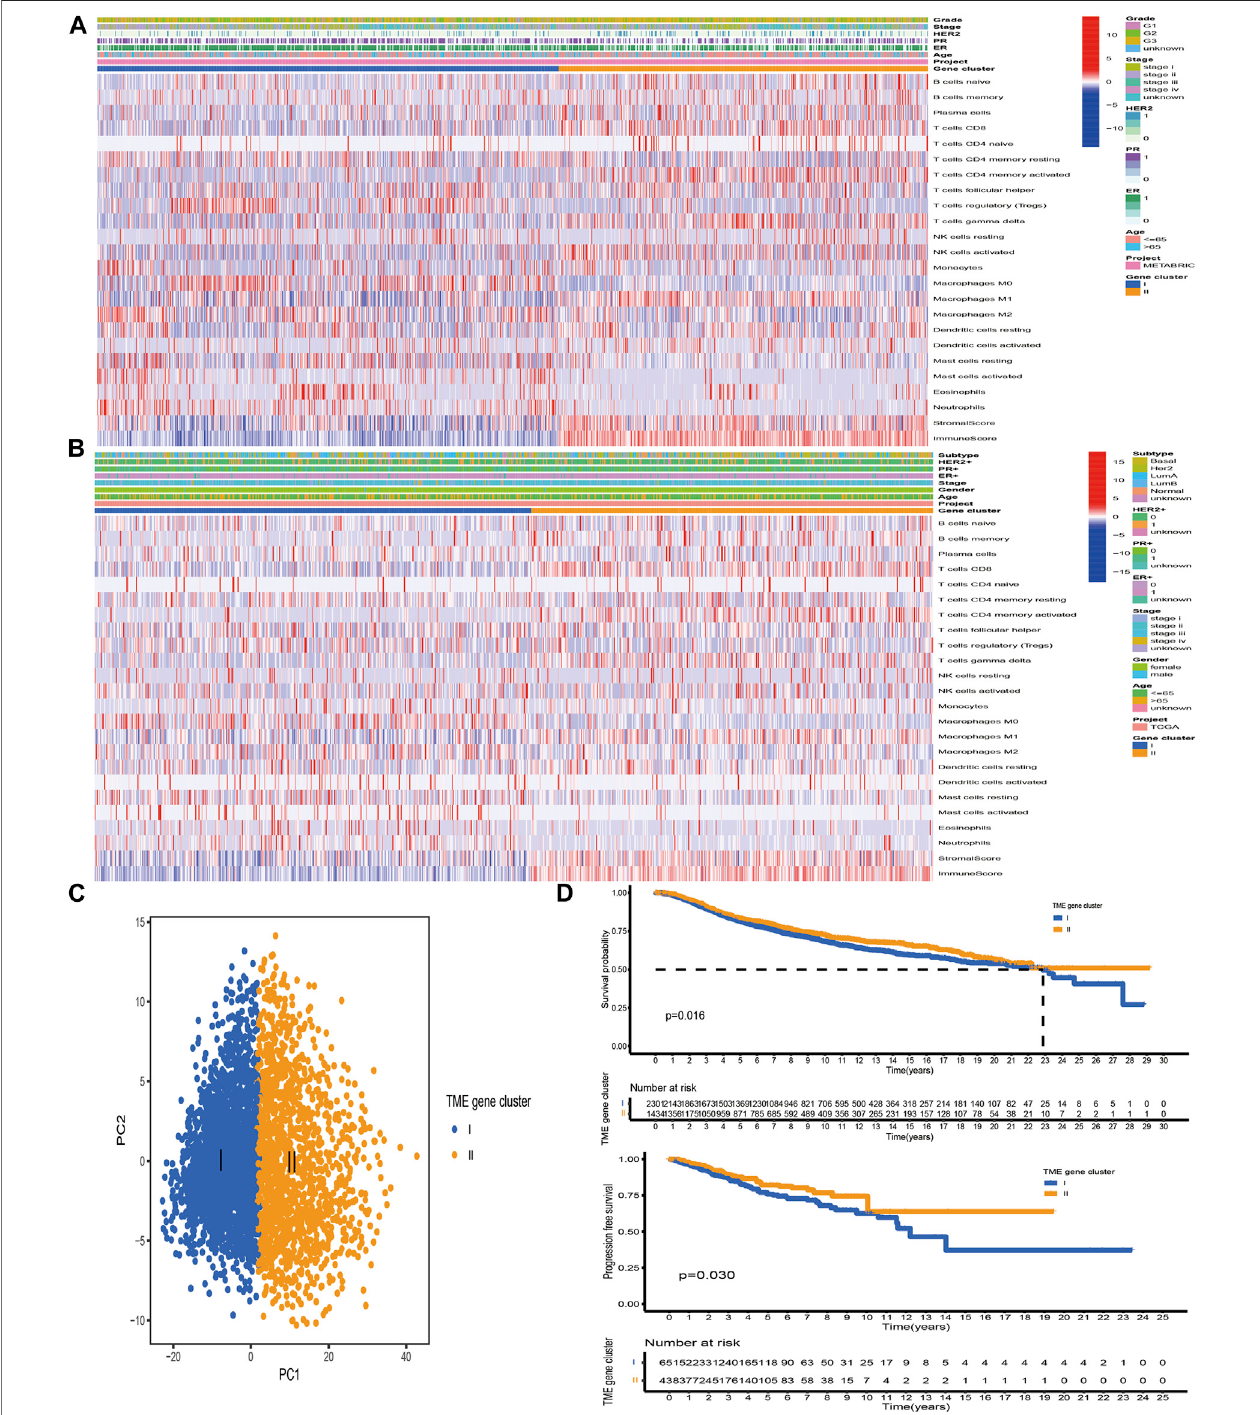
FIGURE 4 | Construction of TME-related gene signature. (A, B) Unsupervised clustering of TME-related signature genes in the TCGA and METABRIC datasets. Clinicopathological information including age, gender, ER, PR, HER2, stage, grade, and molecular subtype is shown in annotations above. Red represented the high expression, while blue represented the low expression. (C) PCA based on the TME-related gene signature could satisfactorily distinguish between TME gene cluster I and II. (D) The Kaplan – Meier curves of OS and PFS for BC samples in the meta-cohort and TCGA-BRCA dataset, respectively.